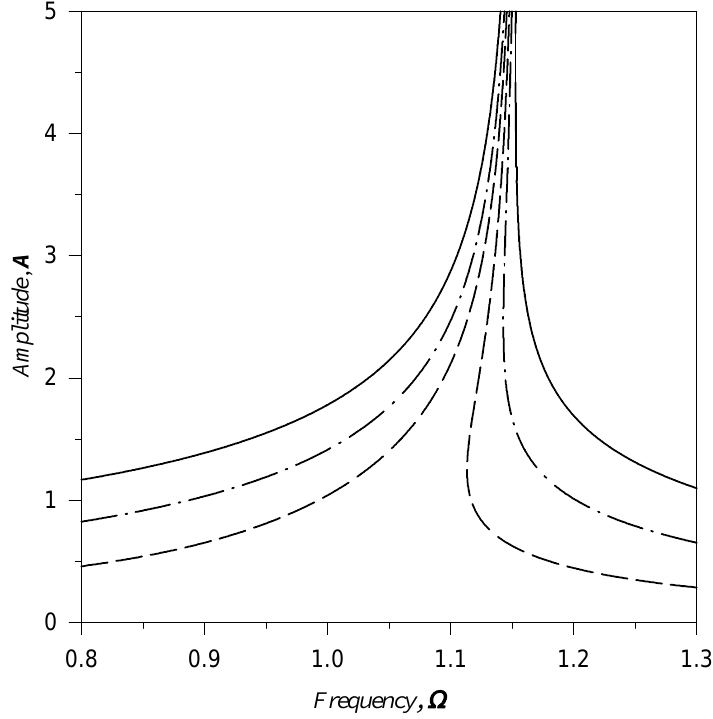
Fig. 7. Steady state frequency response of the first mode, for the concentrated load case obtained using SHB, i.e. ε 1 = 1 . 0449 , ε 2 = 0 . 9329 , ε 3 c = 0 . 17974 , δ = 0 . 02 . —— P = 1 . 0 , – - – P = 0 . 5 , – – – P = 0 . 2 . and length l = 2 m. The fluid is taken to be water ρ (cid:1) = 1000 Kg/m 3 , so that K m = 1 / 2 . 8 . The